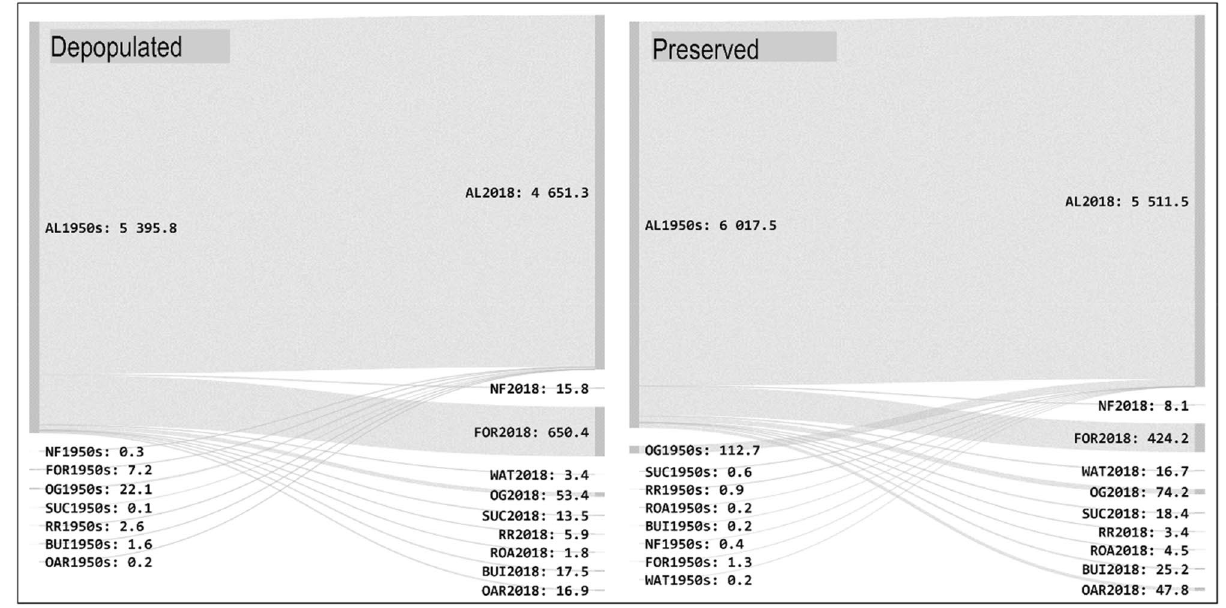
Figure 2. Overall change of agricultural land—change in trajectories between 1953 and the recent time horizon (in hectares). For land cover category codes see Table